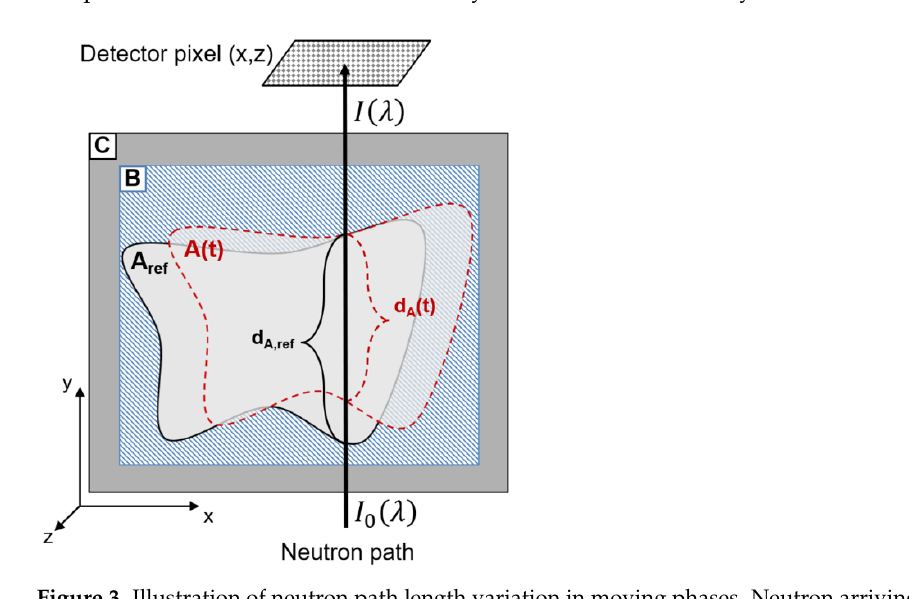
Figure 3. Illustration of neutron path length variation in moving phases. Neutron arriving at a given detector pixel after passing through a nested multiphase system ( A – C ) with one moving phase ( A ) will encounter a shorter path length through ( A ) when that phase moves as shown.